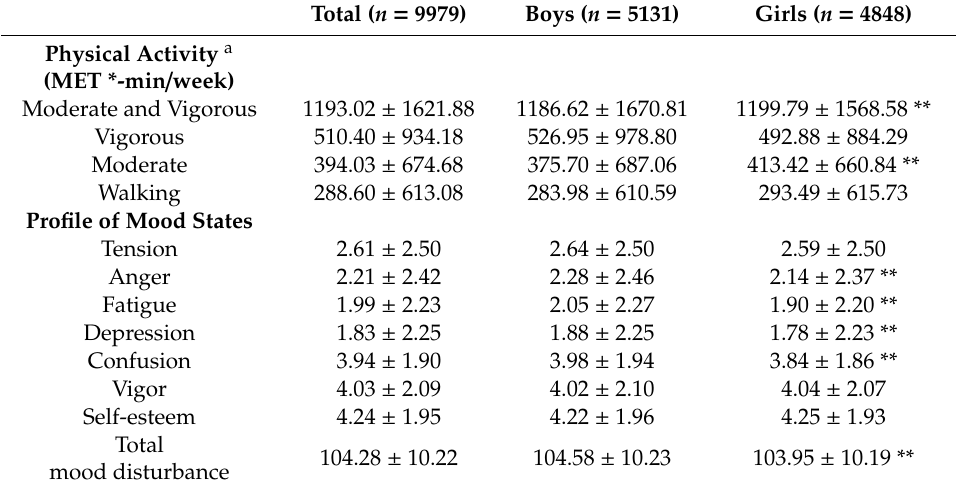
Table 2. Comparison of physical activity and mood states between di ff erent sexes ( N = 9979).